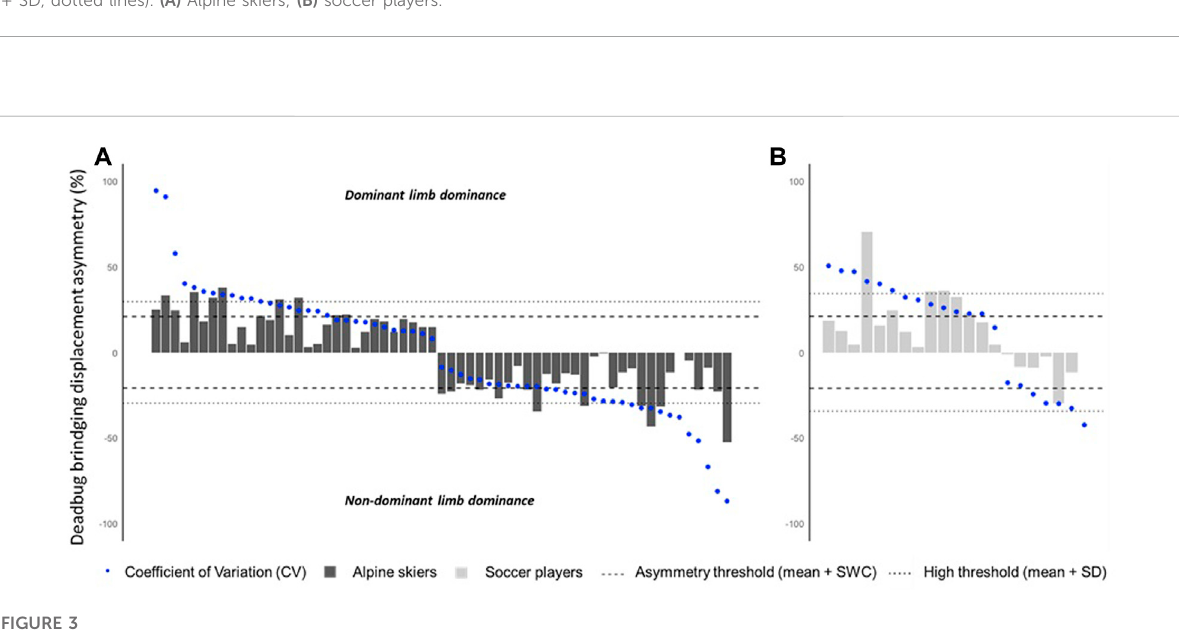
FIGURE 2 (A,B) Individual medial knee displacement (MKD) asymmetry data (bars) with the respective coef fi cient of variation (blue bullet points), threshold for smalltomoderateasymmetry[populationmean+smallestworthwhilechange(SWC),dashedlines],andthresholdforhighasymmetry(populationmean + SD, dotted lines). (A) Alpine skiers; (B) soccer players.